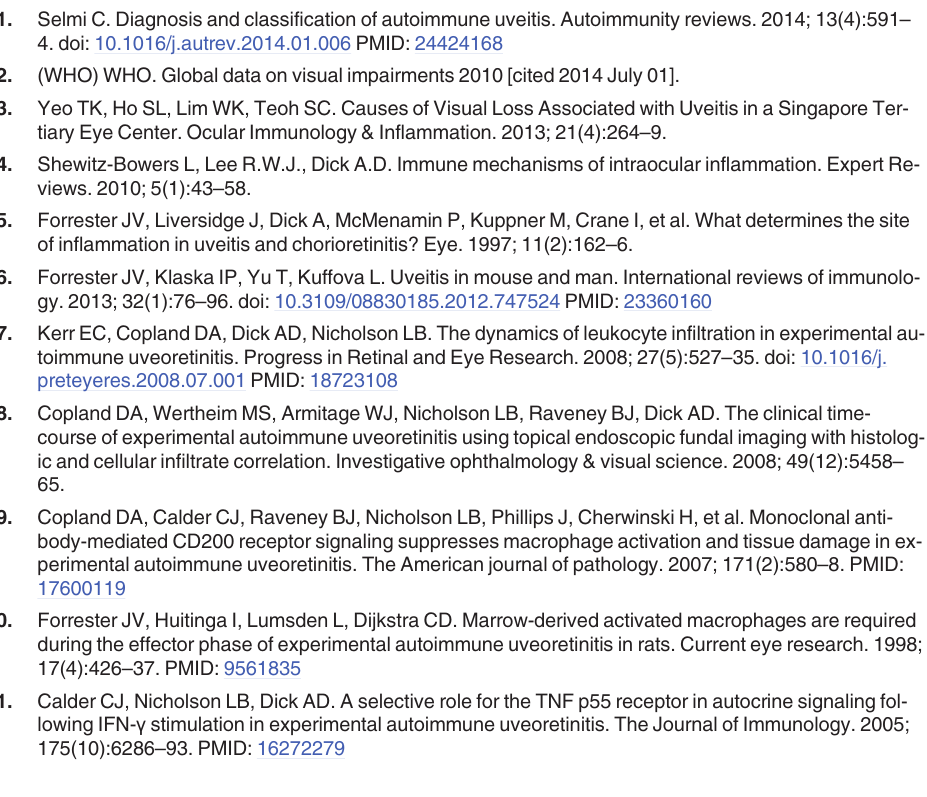
ac- 2 inhibition and B) Lp-PLA enzyme activity calculated 2 2